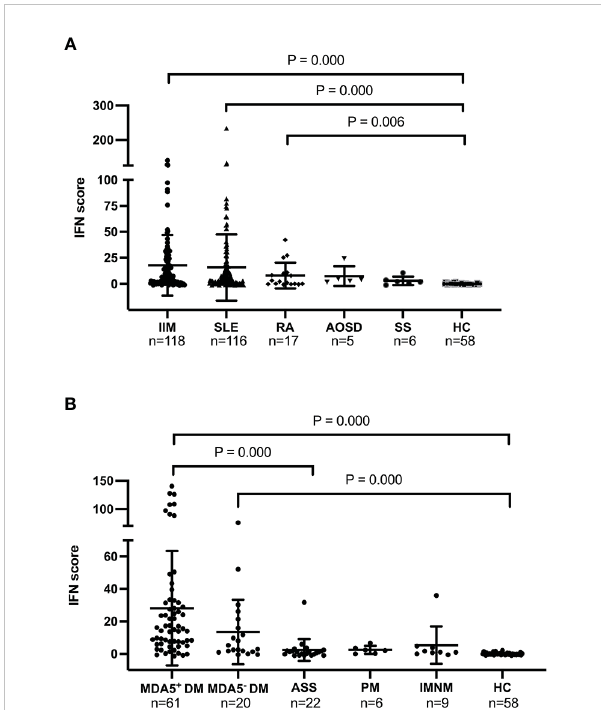
FIGURE 2 Baseline IFN scores in different autoimmune diseases and in healthy controls. (A) . IFN scores in the IIM, SLE, RA, AOSD, SS, and HC groups. (B) . IFN scores in the anti-MDA5+ DM, anti-MDA5 − DM, ASS, PM, INIM, and HC groups. The Kruskal – Wallis test with Bonferroni correction was performed using SPSS software (version 23.0). The IFN score of each individual is represented as a single dot. Horizontal lines represent the mean ± SD. IFN, interferon; IIM, idiopathic in fl ammatory myopathy; SLE, systemic lupus erythematosus; RA, rheumatoid arthritis; AOSD, adult-onset Still ’ s disease; SS, Sjögren ’ s syndrome; HC, healthy